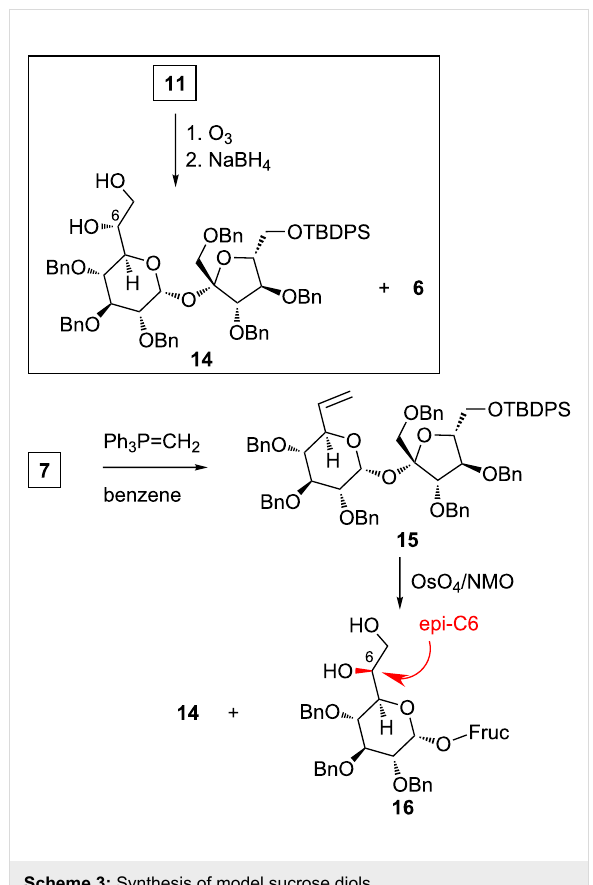
Scheme 3: Synthesis of model sucrose